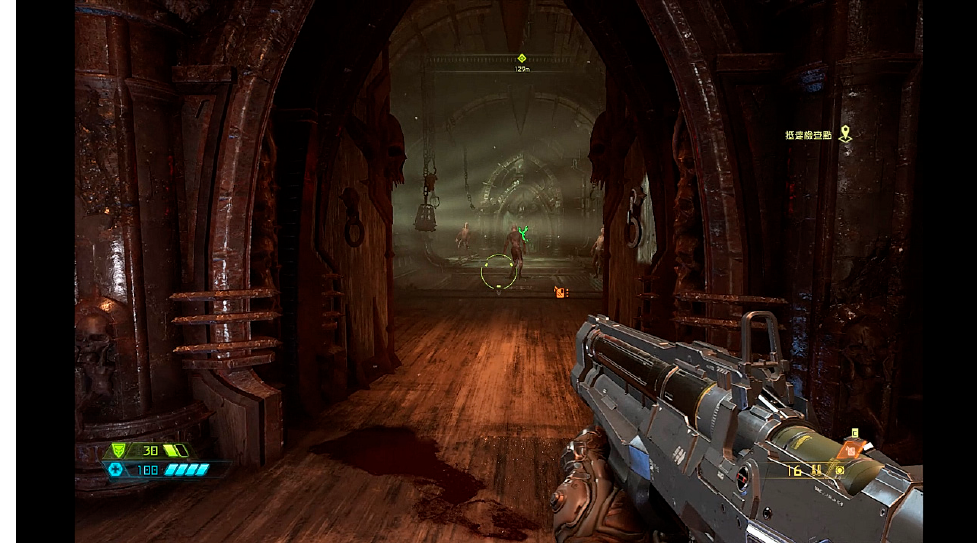
Figure 5. Screenshot of the first-person shooting 2D game used in this study.